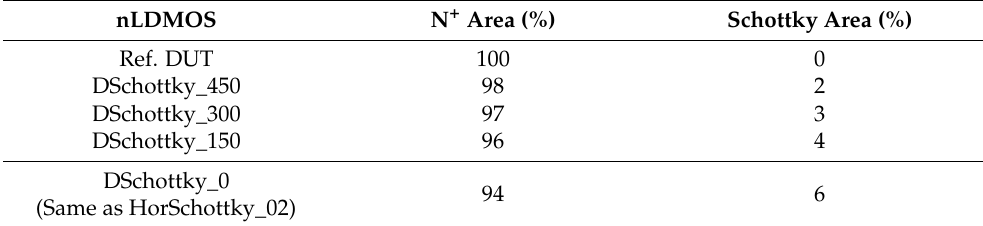
Table 2. Area ratios of N + and Schottky diode regions in the drain electrode. nLDMOS N + Area (%) Schottky Area (%) Ref. DUT 100 0 98